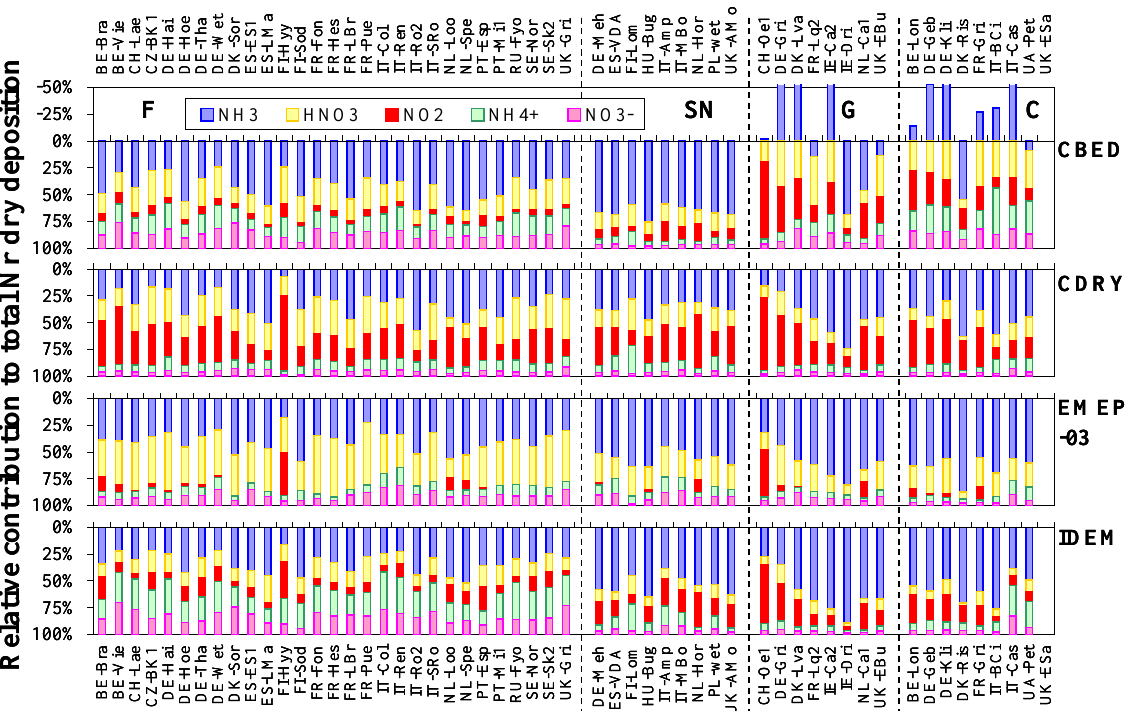
Fig. 5. Relative contributions of N r species to total inorganic N dry deposition. For G and C data in CBED (top panel), negative percentages for NH 3 denote net NH3 emissions, which are expressed relative to the sum of dry deposition fluxes for the other four N r species.